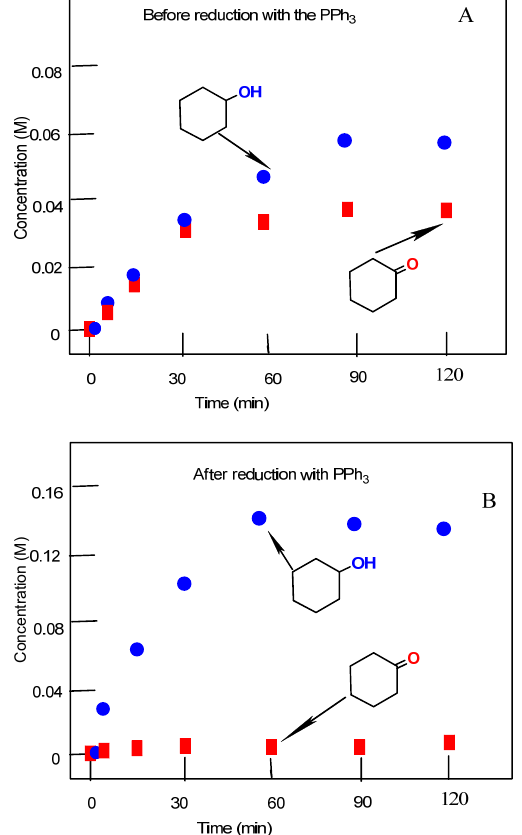
Figure 4. Accumulation of cyclohexanol and cyclohexanone in the oxidation of cyclohexane (0.46 M; 0.125 mL in 2.5 mL total volume) with hydrogen peroxide (2.0 M, 0.32 mL 50% aqueous in 2.5 mL total volume) catalyzed by compound 3 (5 × 10 − 4 M; 3 mg in 2.5 mL total volume) in the presence of HNO 3 (0.05 M; 0.5 mL stock solution in 2.5 mL total volume) in MeCN at 50 ◦ C. Concentrations of cyclohexanone and cyclohexanol were determined before the reduction of the solid PPh 3 ( A ). The same reaction after reducing the aliquots with solid PPh 3 ( B